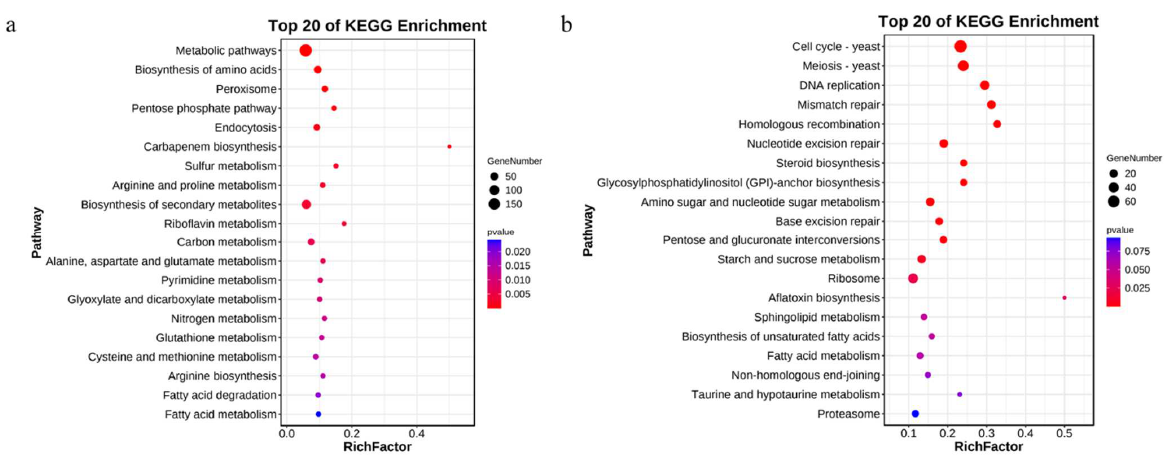
Figure 6. KEGG pathway enrichment analysis of DEGs under different parts of G. dilepis . ( a ): the upregulated genes; ( b ): the downregulated genes.